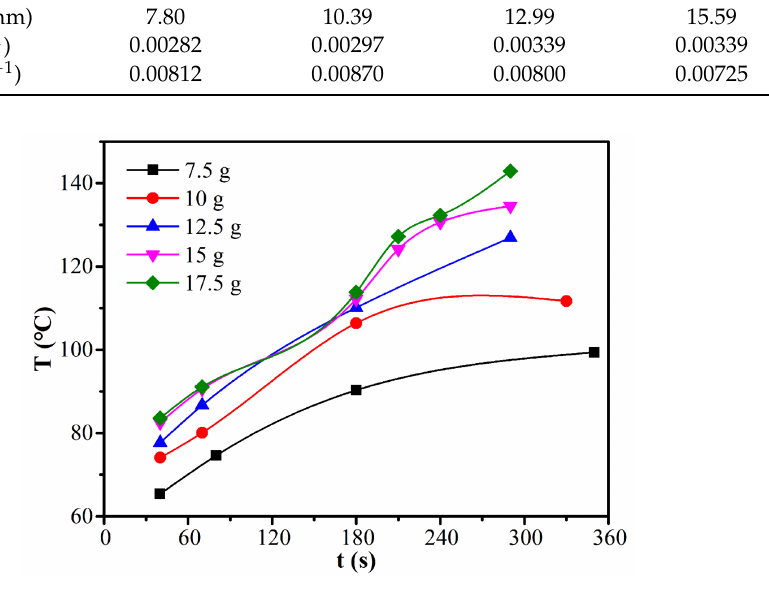
Figure 10. Effect of load mass on the temperature of CRES in the microwave drying